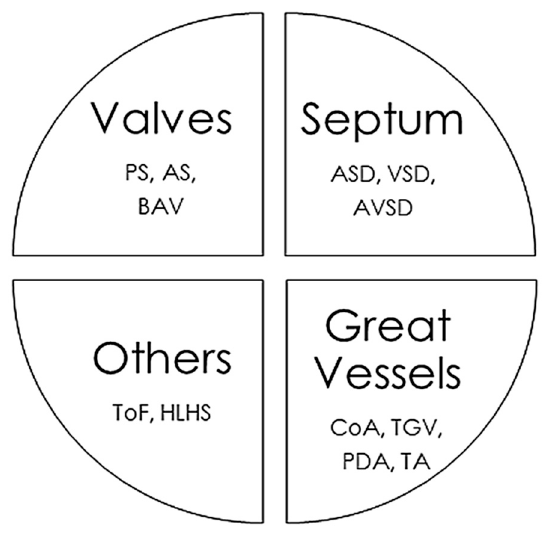
Figure 1. Main congenital heart defects and anatomic alterations. AS, Aortic valvular stenosis; ASD, Atrial septal defect; AVSD, Atrioventricular septal defect; BAV, Bicuspid aortic valve; CoA, Coarctation of the aorta; HLHS, Hypoplastic left heart syndrome, PDA, Persistent ductus arteriosus; PS, Pulmonary stenosis; ToF, Tetralogy of Fallot; TGV, Transposition of great vessels; TA, Common Artery Trunk or Truncus arteriosus; VSD, Ventricular septal defect.